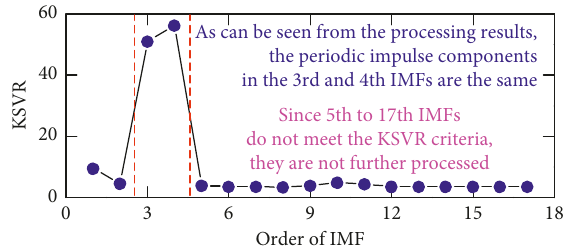
Figure 5: KSVR of each IMF obtained by CEEMDAN.